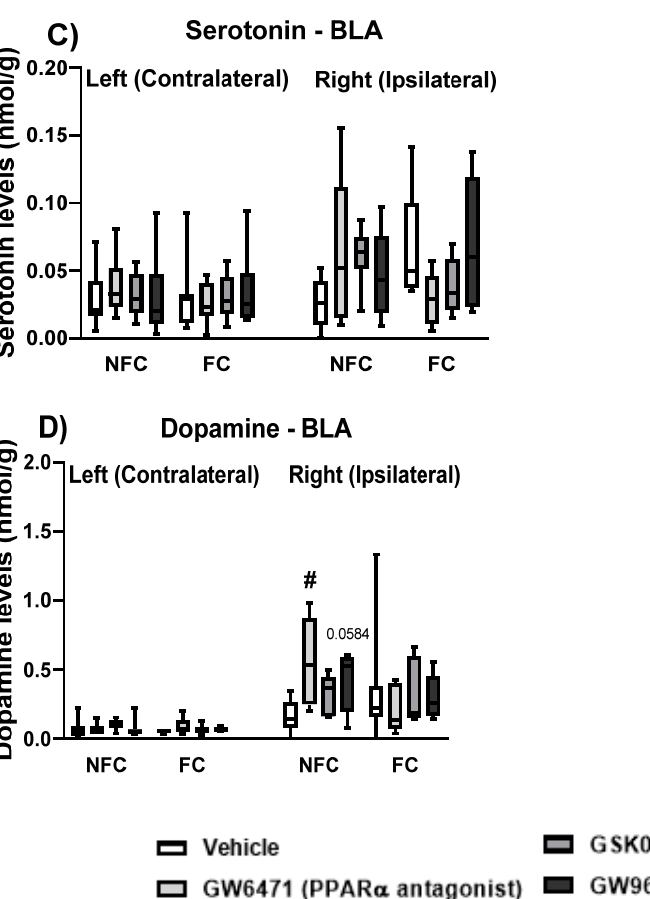
Figure 13. Effects of fear-conditioning and intra-BLA administration of selective PPAR α , PPAR β / δ and PPAR γ antagonists on the tissue levels of GABA ( A ), glutamate ( B ), serotonin ( C ), and dopamine ( D ) in the BLA. Post hoc analysis indicated that NFC rats treated with GW6471 had increased dopamine levels compared to the NFC Vehicle-treated ones ( # p < 0.05). The test also indicated a strong trend for increased levels of dopamine in the NFC GW9662-treated rats compared to the NFC vehicle-treated ( p = 0.0584). Data are expressed as median with interquartile range and min/max ( n = 7–9 rats per group).